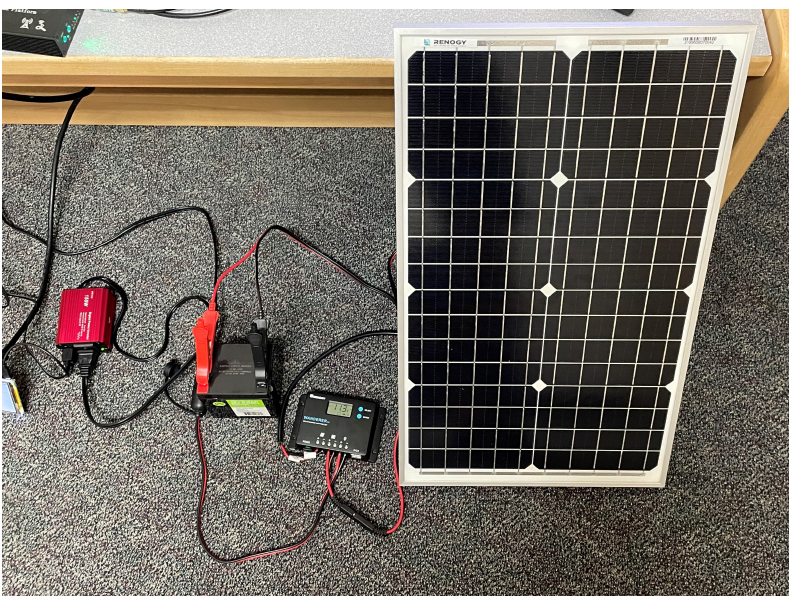
Figure 14. Standalone solar panel power system. The far left red block is the power inverter, to the right of that is the battery, then next is the charge controller, and finally on the far right is the solar panel.